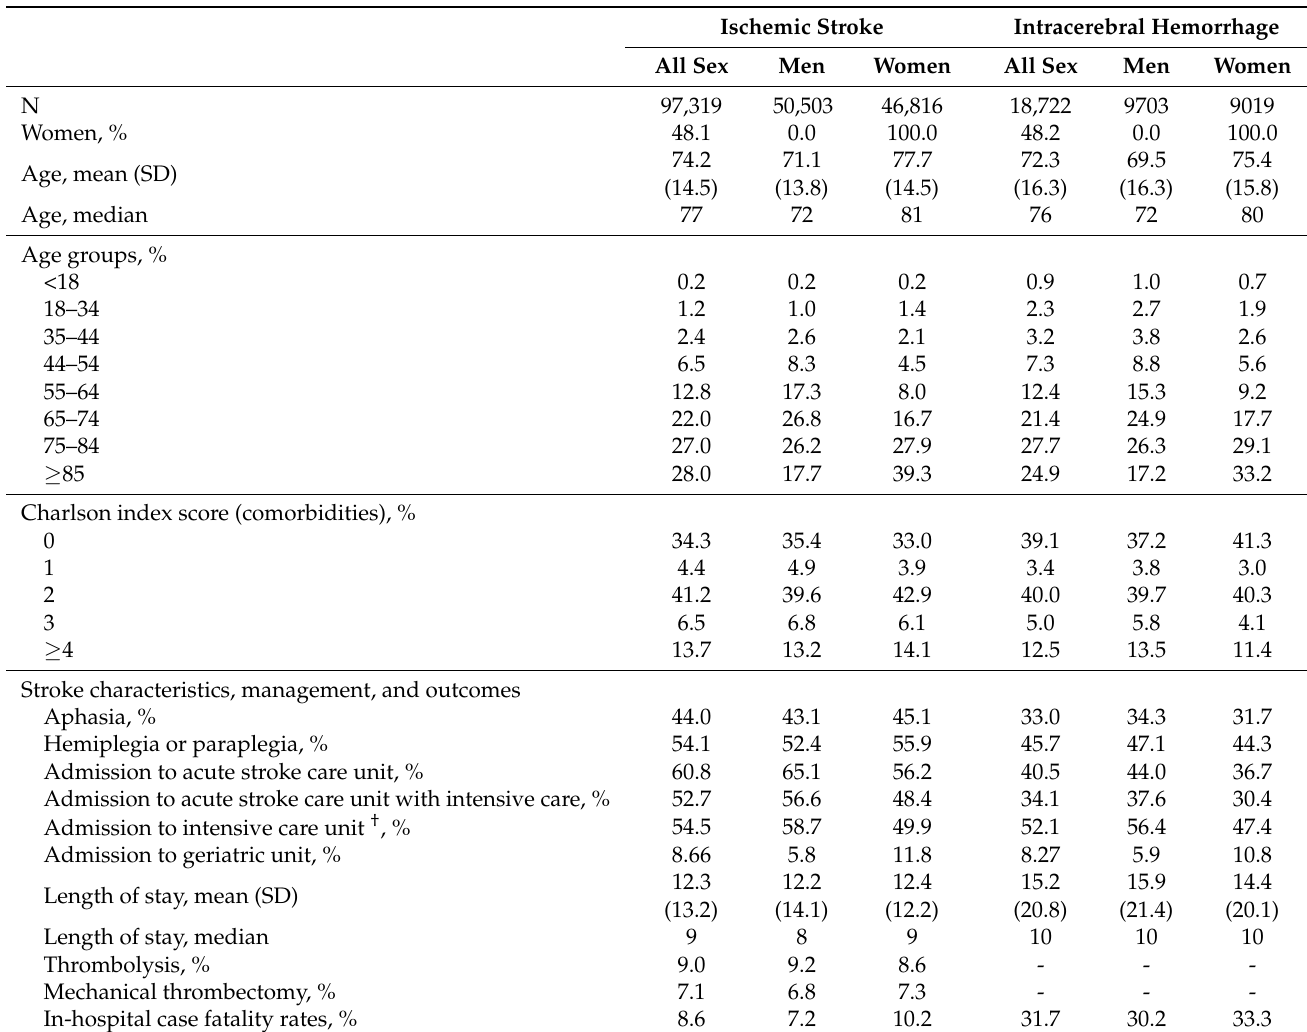
Table 1. Number and characteristics of patients hospitalized for ischemic stroke (IS) and intracerebral hemorrhage (ICH) in France in